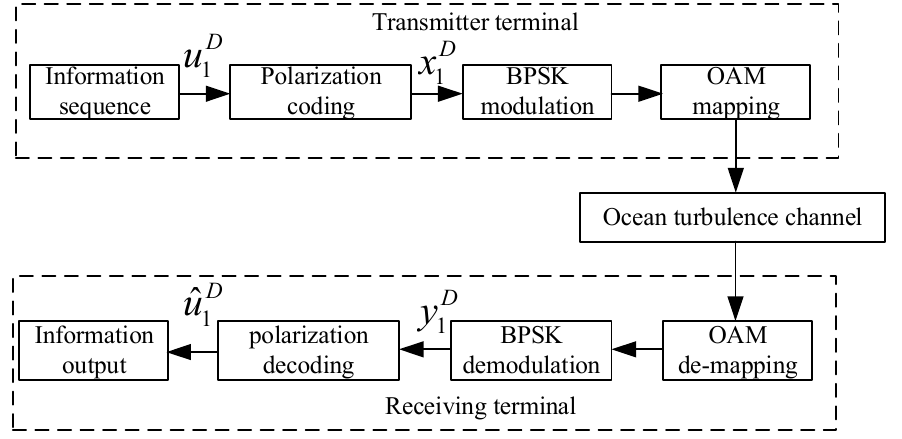
Figure 4. System block diagram.